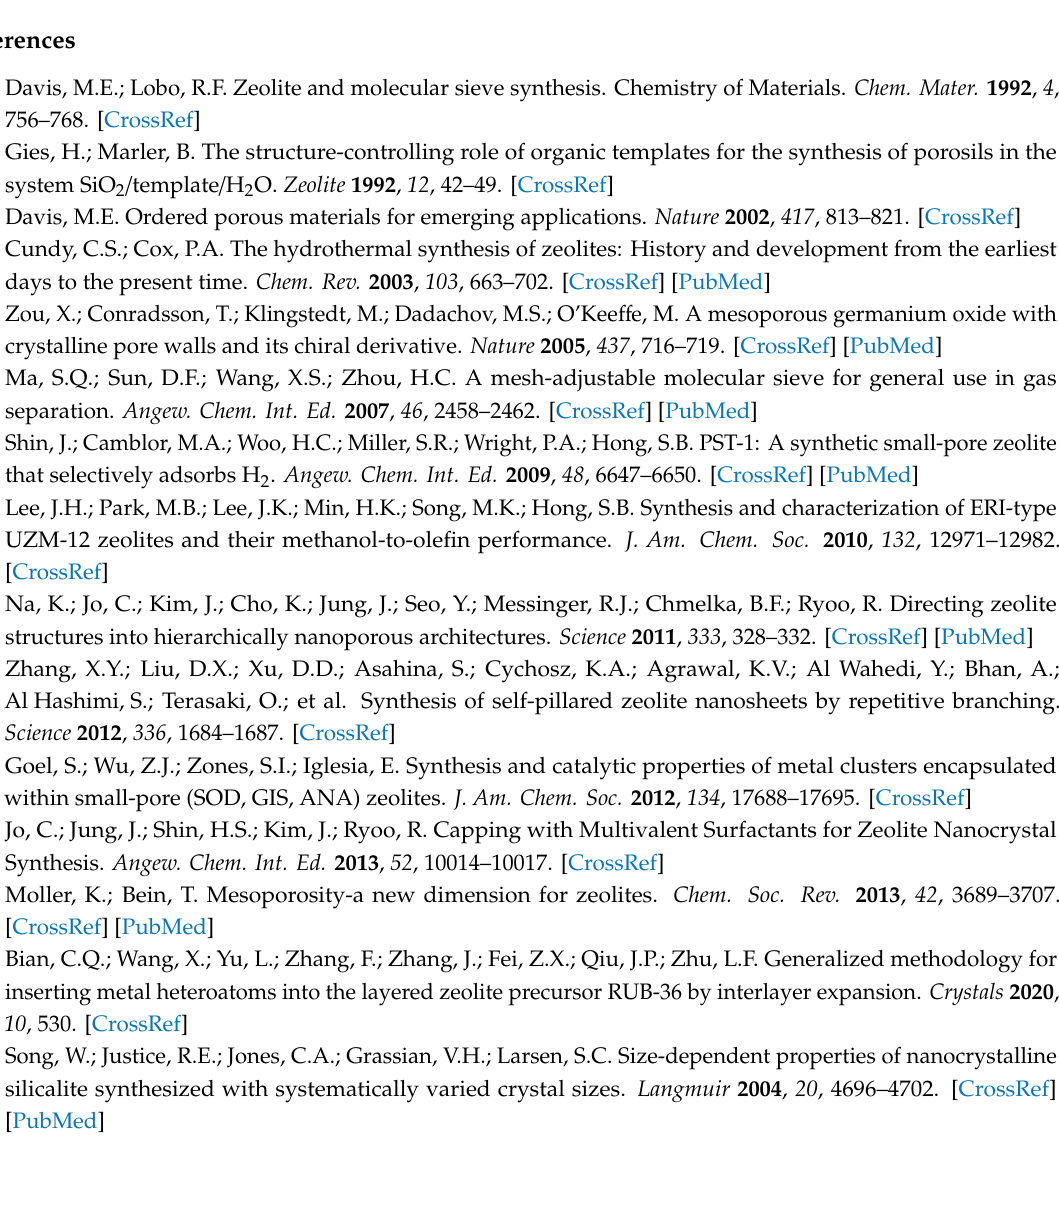
Figure S1: IR spectra of Fe-LTL zeolite crystals synthesized under various conditions in Table